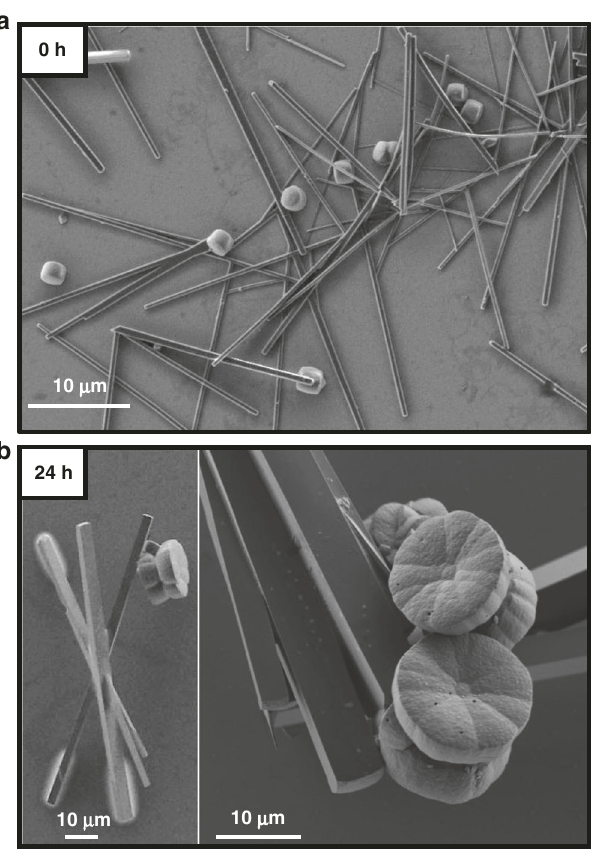
Fig. 5 Ligand-based (TPEPA) crystalline rods and yo-yo-like crystals. Scanning electron microscopy (SEM) images of the reaction products recorded a after the solvothermal reaction and b after 1 day of